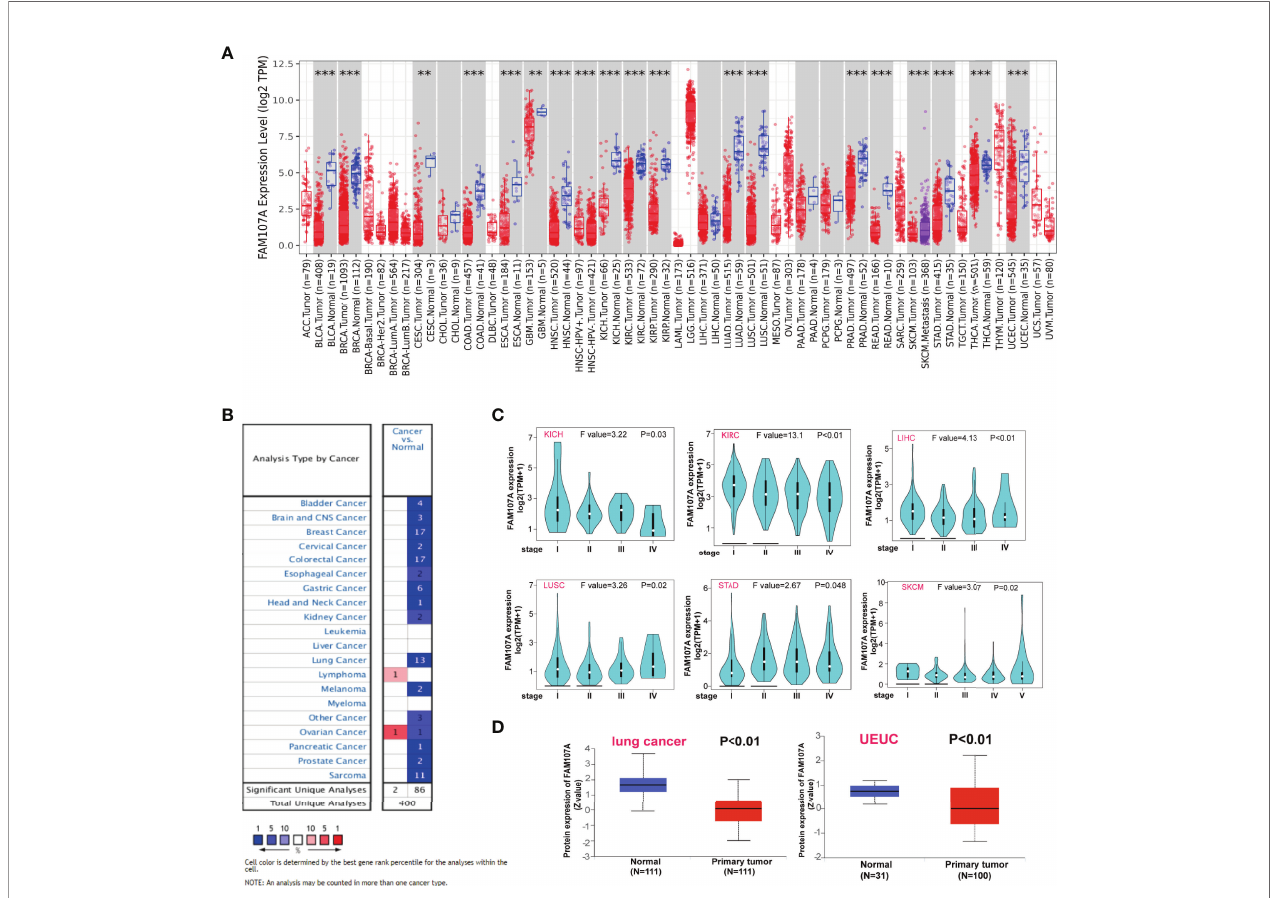
FIGURE 1 | Expression level of FAM107A gene in pan-cancers and pathological stages. (A) The expression status of the FAM107A gene in different cancers or speci fi c cancer subtypes was analyzed through TIMER2. **P < 0.01; ***P < 0.001. (B) The expression status of the FAM107A gene in different cancers was analyzed through Oncomine platform. (C) The expression levels of the FAM107A gene were analyzed by the main pathological stages of KICH, KIRC, LIHC, LUSC, STAD, and SKCM based on the TCGA data. (D) The expression level of FAM107A total protein in primary tumor tissue and normal tissue of lung cancer and UCEC was analyzed based on the CPTAC